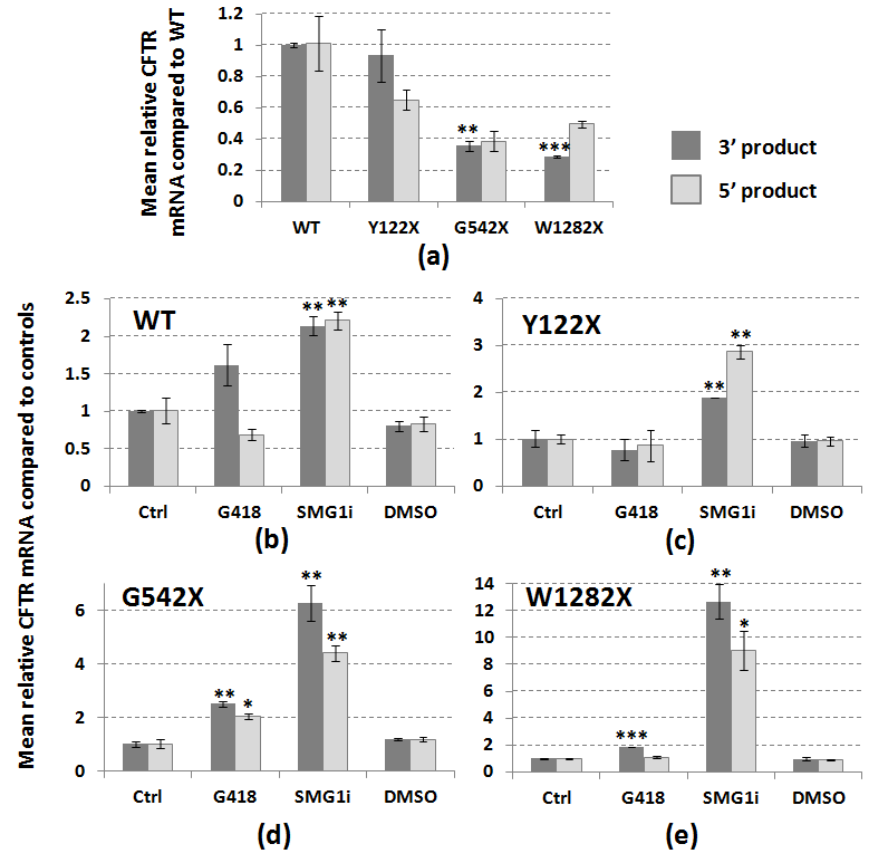
Figure 2. Effect of PTC mutations on abundance of CFTR mRNA and rescue using PTC readthrough and NMD inhibition. Graphs show relative quantification of CFTR mRNA amplified by RT-qPCR using primers designed at 3 ′ and 5 ′ ends (dark vs. light bars, respectively). ( a ) Relative abundance of 5 ′ and 3 ′ fragments with three different PTC mutations (Y122X, G542X, and W1282X) compared with wt-CFTR. ( b – e ) Effect of PTC readthrough (G418, 250 µg/mL, 24 h), NMD inhibition (SMG1i, 0.5 µ M, 24 h), or DMSO (0.5%, 24 h) on abundance of 3 (cid:48) and 5 (cid:48) CFTR for four different genotypes (b: wt; c: Y122X; d: G542X; e: W1282X). Ctrl = untreated cells. Values shown are means ( n = 3, except for wt-Ctrl: n = 2) ± SEM, and significant differences from respective control conditions are indicated by asterisks (* p < 0.05; ** p < 0.01; *** p <